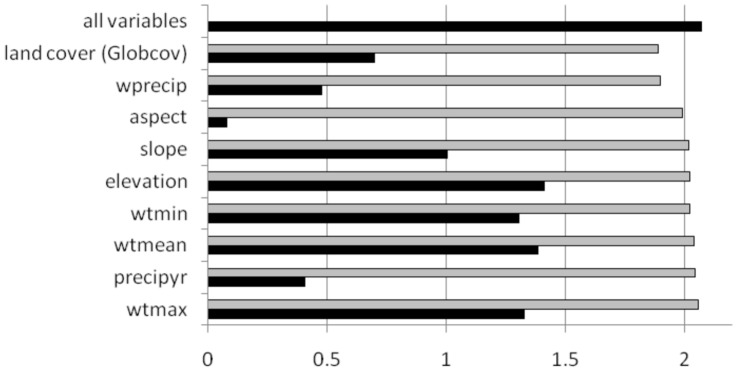
Training gain for each predictor variable alone (black) and the loss in training gain when the variable is removed from the full model (gray).